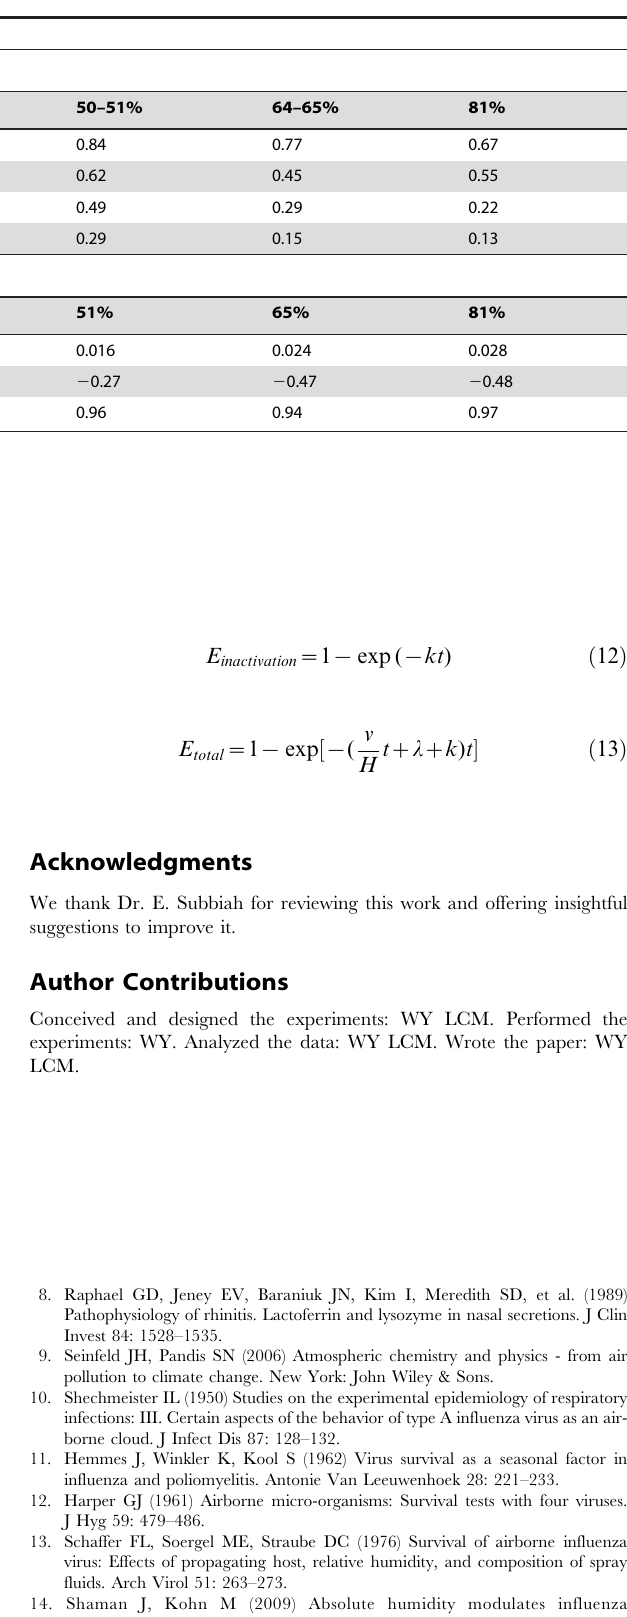
Table 3. Inactivation of airborne IAVs at 20–24.5 u C over 1 h.